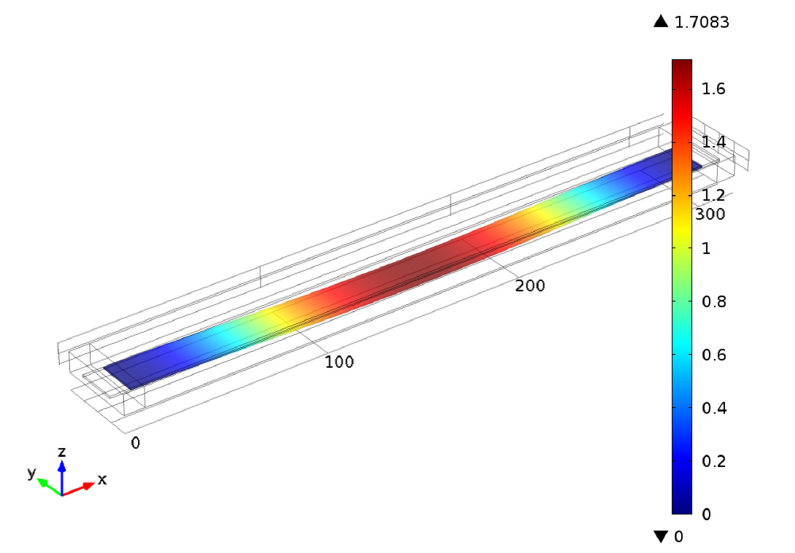
Figure 5. The shape of the fixed-fixed beam in the state of maximum deformation while performing periodic oscillations according to the first computational